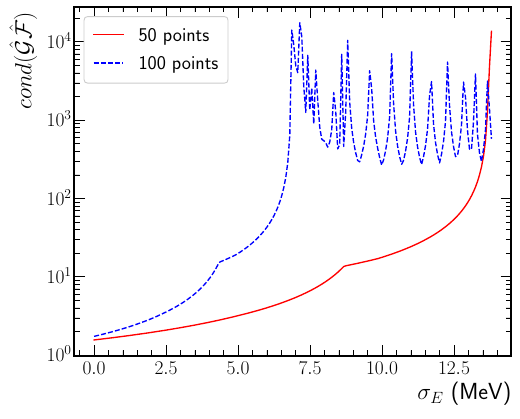
(a) The case of 50 (solid curve) and 200 (dashed curve) c.m. energy points equally spaced in the range 1 . 18 - 2 . 00 GeV. Figure 4. The dependence of the condition number cond ( ˆ G ˆ F ) on the c.m. energy spread.